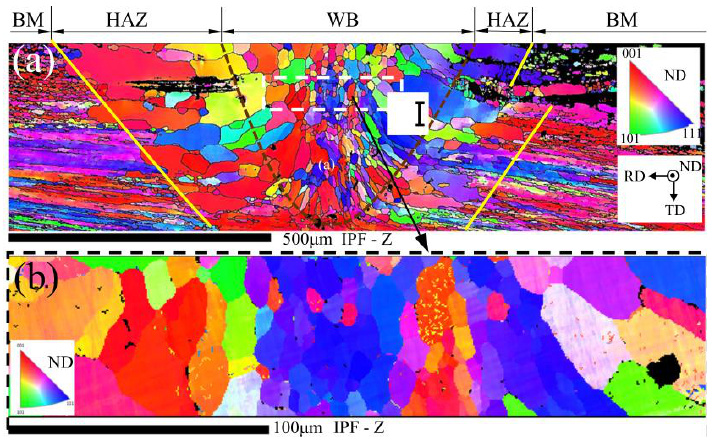
Figure 1. ( a ) Electron backscatter diffraction (EBSD) image of cross section of Mo joint achieved by laser welding, and ( b ) enlarged view of area ( a ) [10].